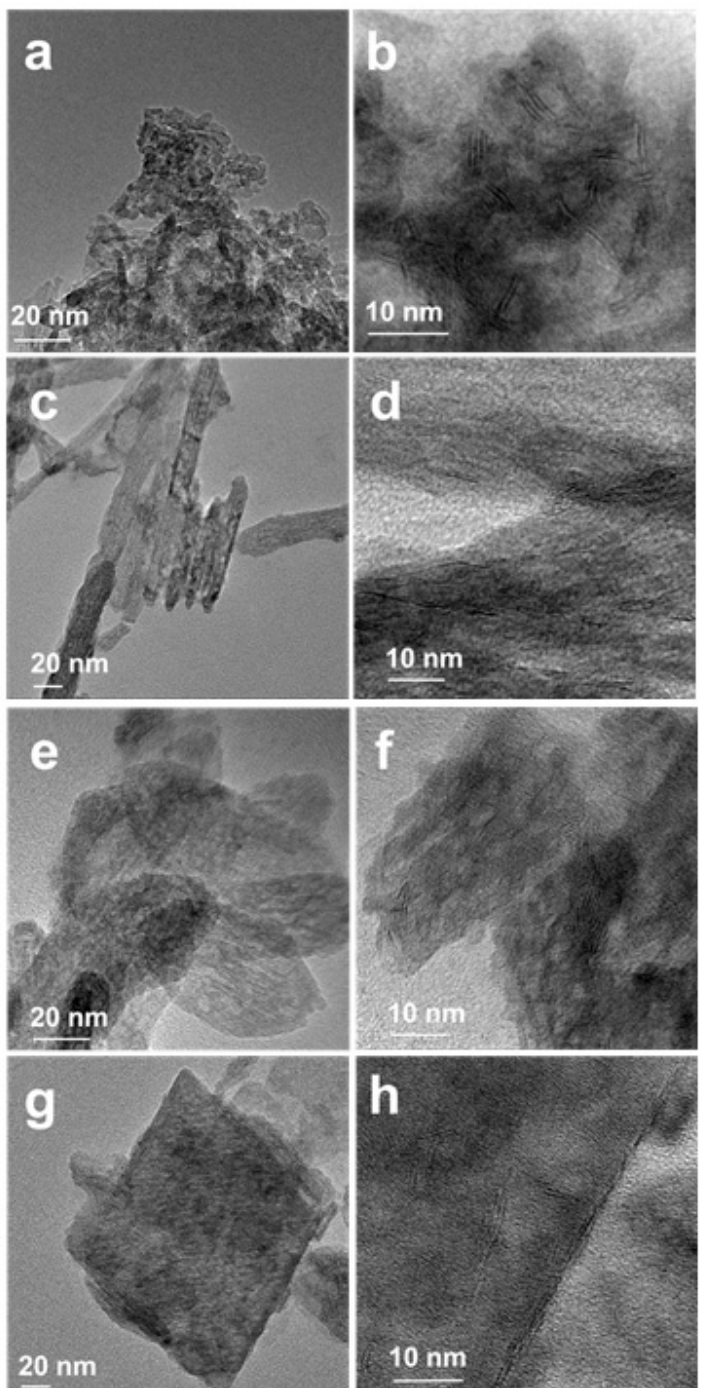
Figure 6. Typical HRTEM images of sulfided ( a , b ) NiMo/CA, ( c , d ) NiMo/AN, ( e , f ) NiMo/AH, ( g , h ) NiMo/AR catalysts.